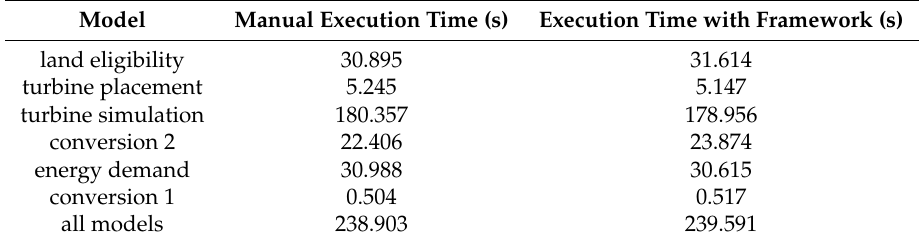
Table 2. Comparison of execution time with and without the